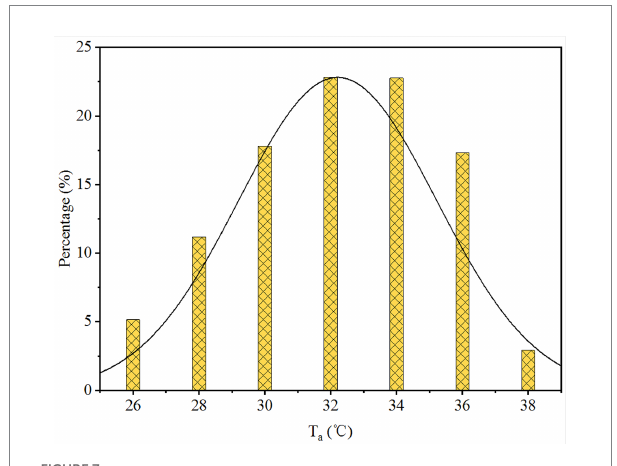
FIGURE 7 Distribution of air temperature. T a , air